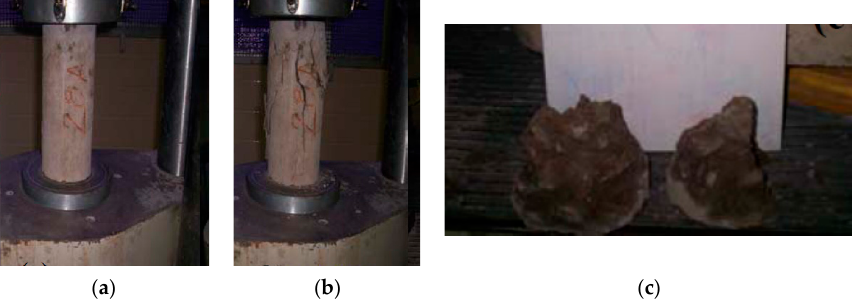
Figure 2. Compressive strength test view: ( a ) sample in the press, ( b ) broken sample, and ( c ) rupture of the specimen (age of 28 days and 15% sludge).